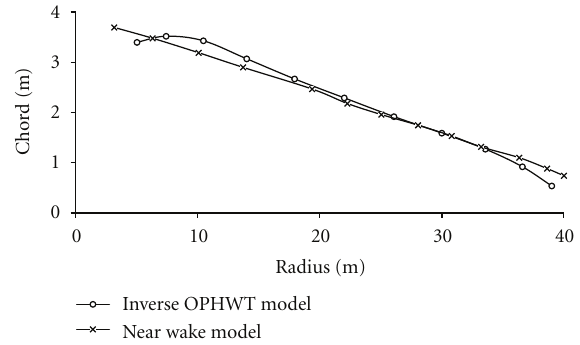
Figure 6: Span wise variation of the chord in the kinetic energy model for N b = 3 and α = 8 ◦ .